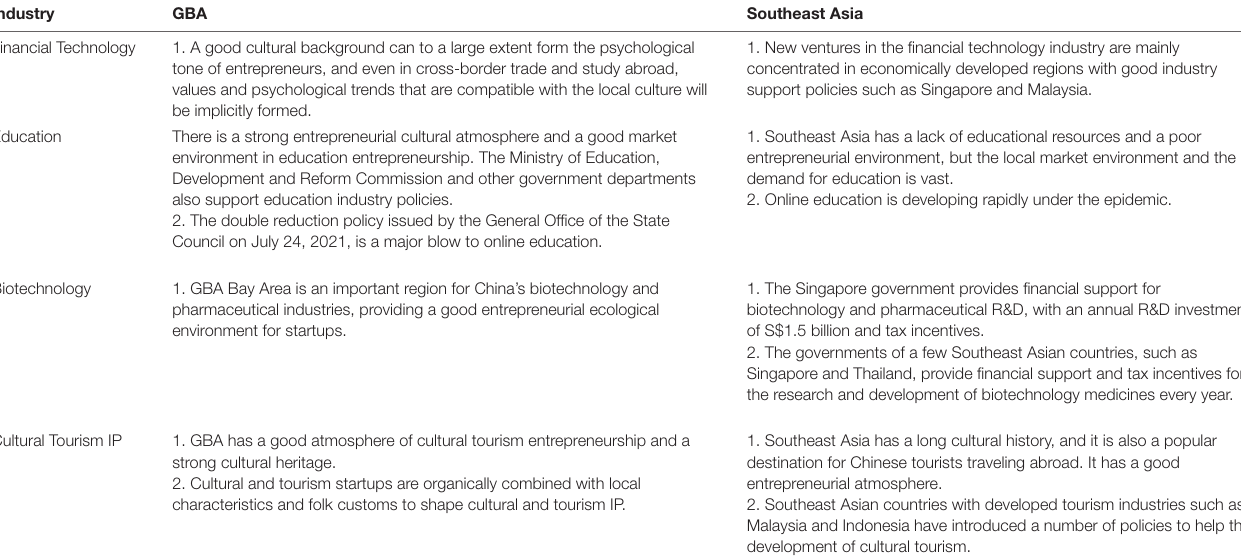
TABLE 6 | The commonality of each of the four industries in the two regions. Industry GBA Southeast Asia Financial